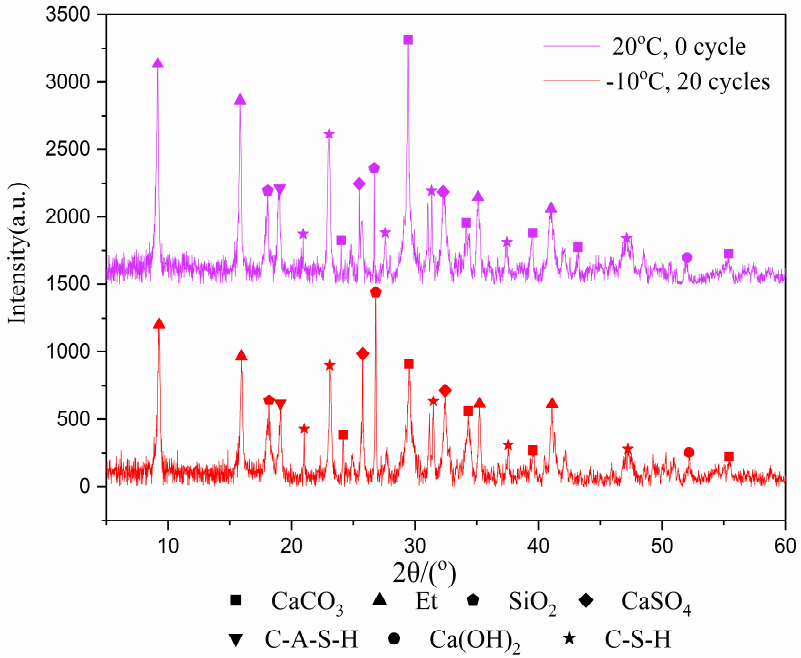
Figure 4. XRD image of 28-day samples.